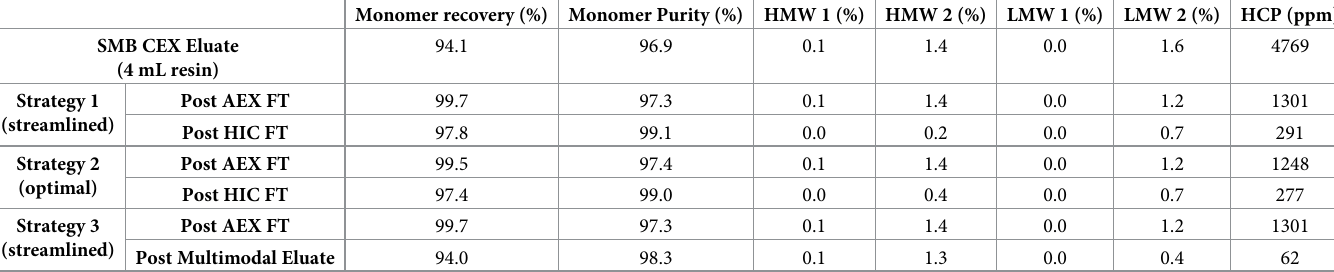
Table 3. Evaluation of suitable polishing steps for SMB CEX eluate. All polishing runs were performed with 1 mL columns.